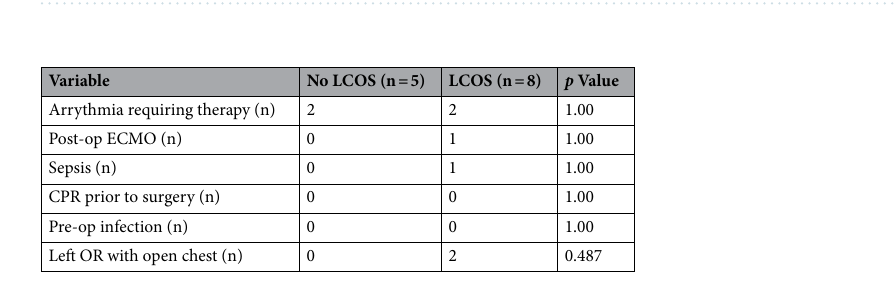
Table 2. Post-operative complications. CPR Cardiopulmonary resuscitation, ECMO Extra corporeal membrane oxygenation, OR Operating room.